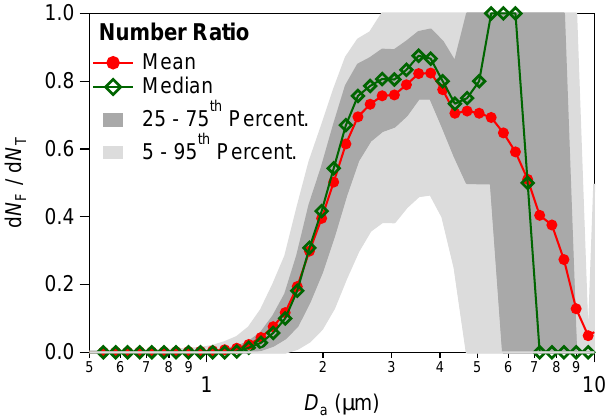
Fig. 3. Average size distribution of FBAP to total ratio for the mea- surement campaign (d N F /d N T = d M F /d M T )